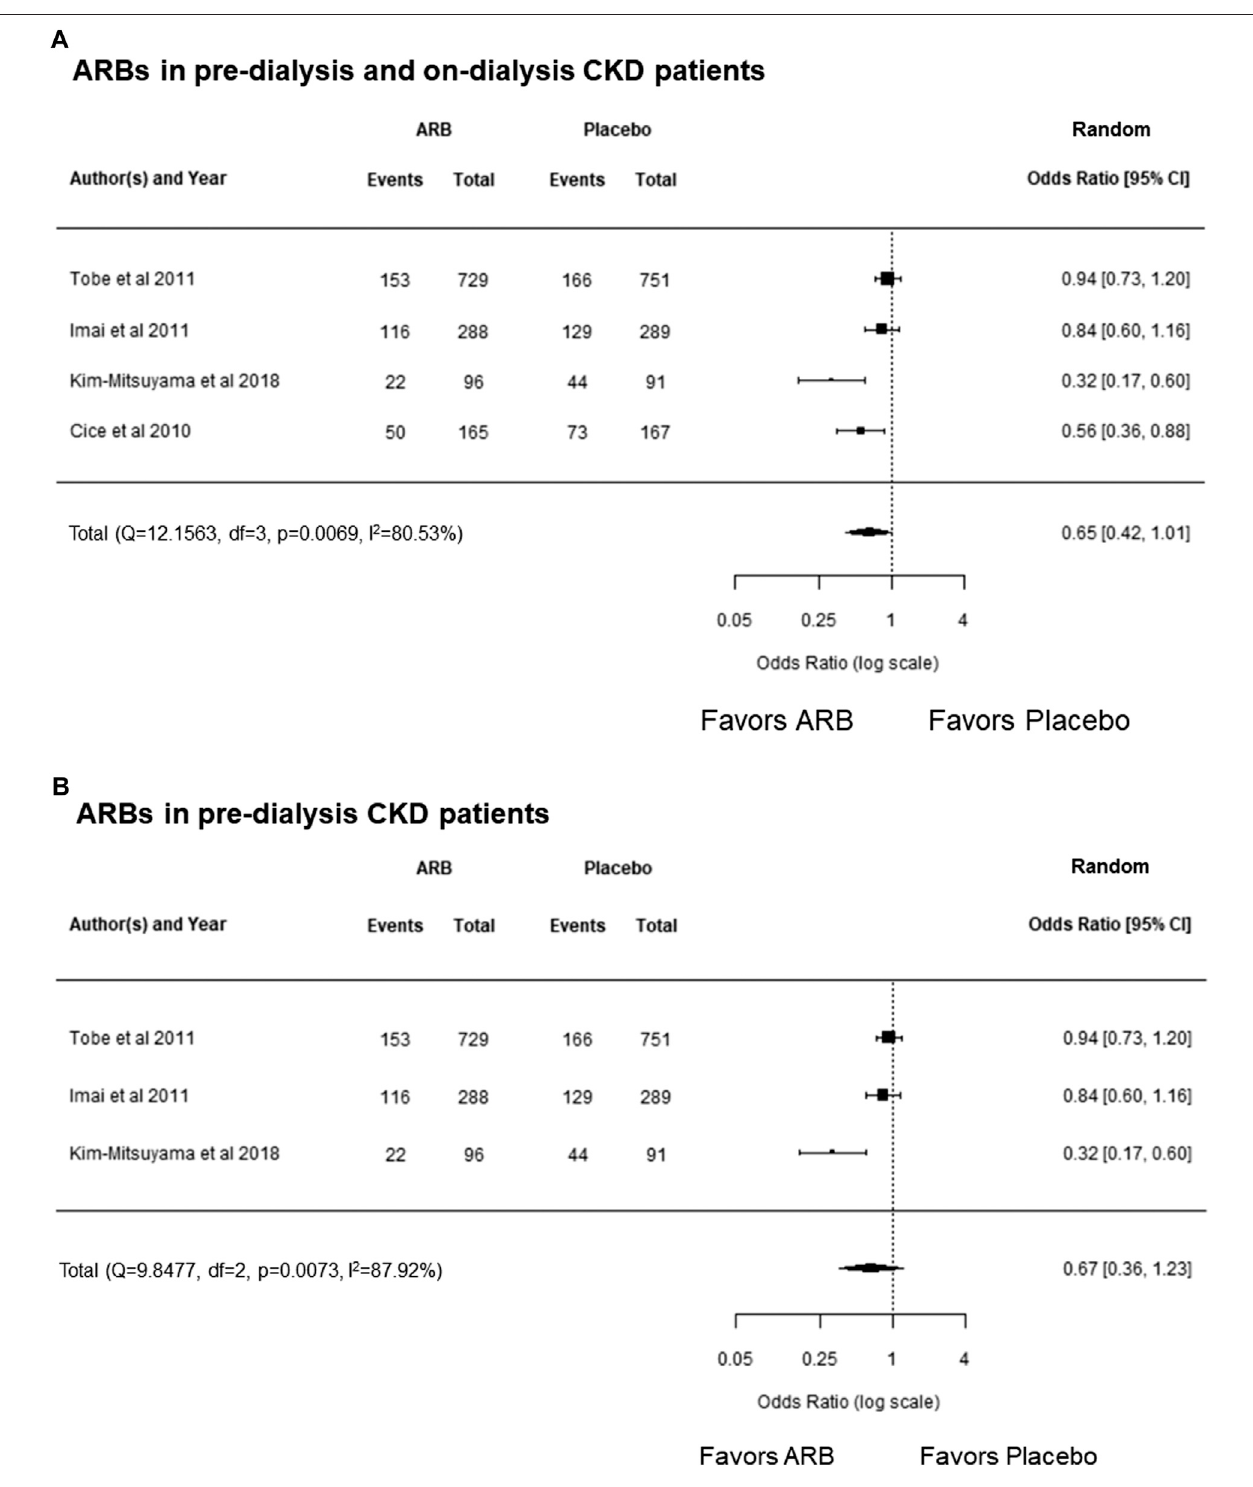
FIGURE 4 | (A) Forest plot describing a comparison of the incidence of cardiovascular events between ARBs and placebo in pre-dialysis and on-dialysis patients with CKD. (B) Forest plot describing a comparison of the incidence of cardiovascular events between ARBs and placebo in pre-dialysis patients with CKD. ARB, angiotensin receptor blocker; CI, con fi dence intervals; CKD, chronic kidney disease.